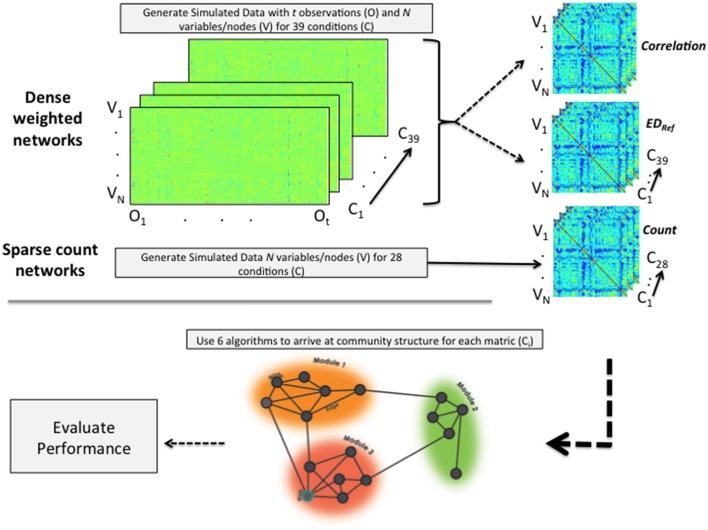
Depiction of data simulation and analytic process. For dense weighted networks, time series data are generated. From these, correlation and (reflected) Euclidean distance matrices are computed. Sparse count matrices are made directly using the LFR benchmark simulation program. All data generated across all conditions are then subjected to each of the 6 community detection algorithms and their performance evaluated. “V” indicates variable or node; “O” indicates the observation, and “C” the condition.